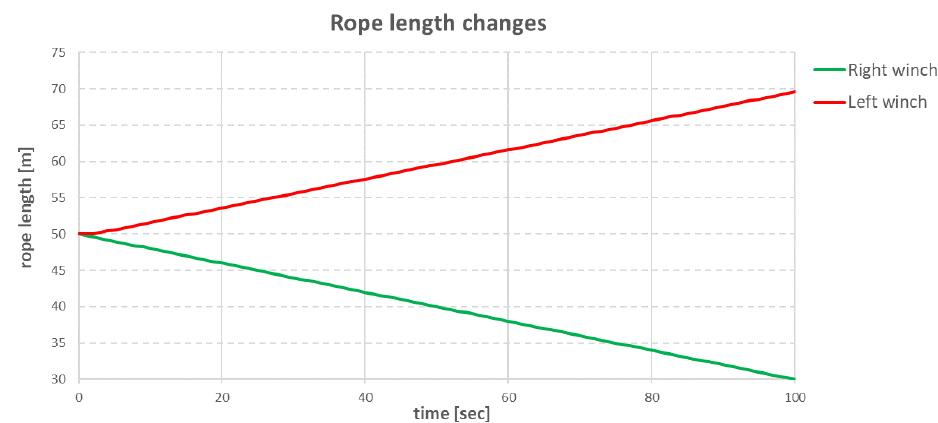
Figure 29. Changes in the length of individual ropes over time.